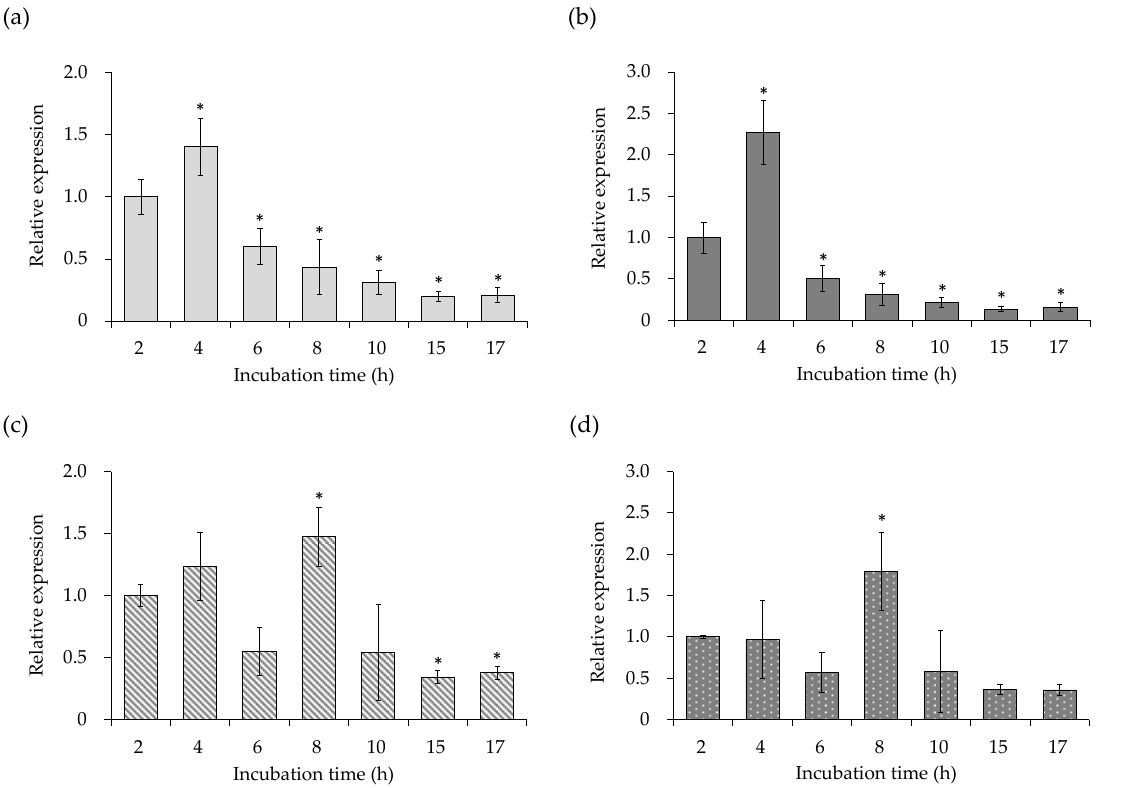
Figure 1. Time-dependent changes in the expression level of the virulence factor of Staphylococcus aureus C-29. Gene expression of ( a ) staphylococcal enterotoxin A ( sea ), ( b ) RNAIII, ( c ) phenol-soluble modulin α 1 ( psm α 1), and ( d ) psm α 3. S. aureus C-29 (10 8 cells/mL) was inoculated into BHI and incu- bated at 37 °C with shaking. Bacterial cells were collected after 2, 4, 6, 8, 10, 15, and 17 h. Then, RNA extraction and real-time RT PCR were performed. The data are expressed as the mean ± SE of three or more independent experiments. * represents p < 0.05 compared to 2 h.